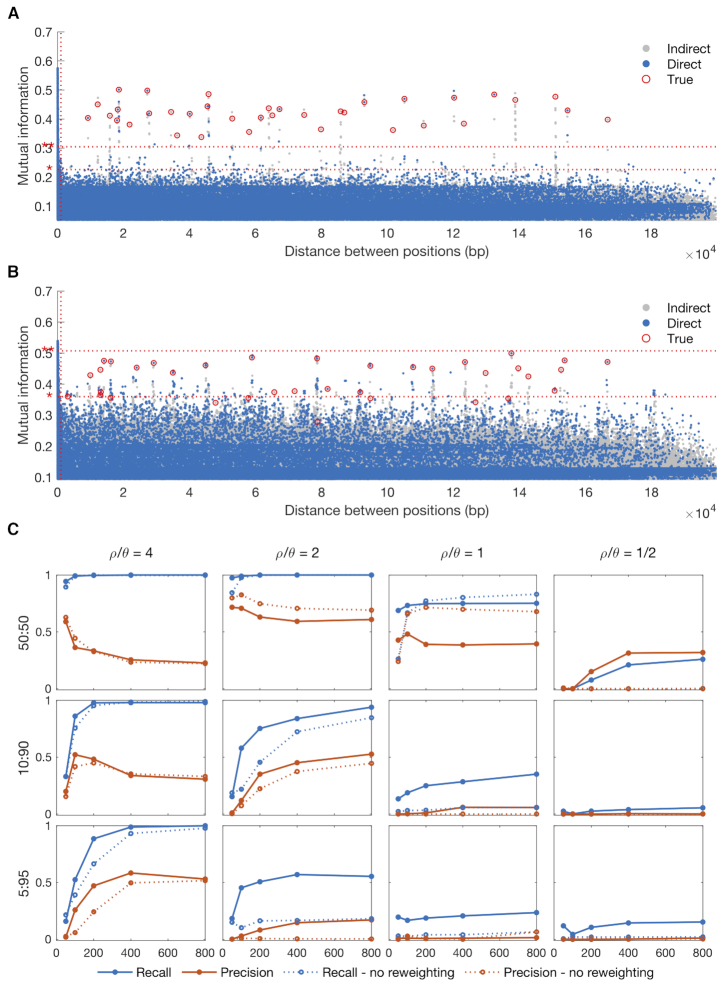
Simulated data: (A and B) GWES Manhattan plot for two example cases with 400 sequences generated under equal-sized populations and (A) \documentclass[12pt]{minimal}
\usepackage{amsmath}
\usepackage{wasysym} 
\usepackage{amsfonts} 
\usepackage{amssymb} 
\usepackage{amsbsy}
\usepackage{upgreek}
\usepackage{mathrsfs}
\setlength{\oddsidemargin}{-69pt}
\begin{document}
}{}$\rho /\theta = \ 2$\end{document} and (B) \documentclass[12pt]{minimal}
\usepackage{amsmath}
\usepackage{wasysym} 
\usepackage{amsfonts} 
\usepackage{amssymb} 
\usepackage{amsbsy}
\usepackage{upgreek}
\usepackage{mathrsfs}
\setlength{\oddsidemargin}{-69pt}
\begin{document}
}{}$\rho /\theta = \ 1$\end{document}. Direct and indirect links are represented by blue and gray dots, respectively, and true links by red circles. The red horizontal dotted lines show the outlier thresholds; outlier * and extreme outlier **. The red vertical dotted line shows the LD threshold. (C) Precision and recall for the outlier links at different sample sizes. Each row of plots represents a population size ratio and each column a \documentclass[12pt]{minimal}
\usepackage{amsmath}
\usepackage{wasysym} 
\usepackage{amsfonts} 
\usepackage{amssymb} 
\usepackage{amsbsy}
\usepackage{upgreek}
\usepackage{mathrsfs}
\setlength{\oddsidemargin}{-69pt}
\begin{document}
}{}$\rho /\theta$\end{document} value.